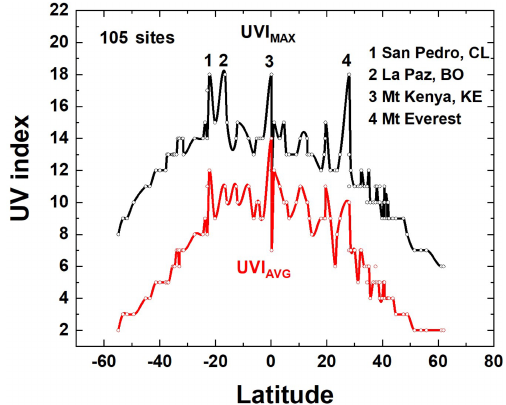
Figure 8. Fourteen-year UVI average and UVI maximum from Ta- ble A4 for 105 sites. Solid curves are Akima spline fits (Akima, 1970) to the individual site data points. There are four high-altitude sites listed: San Pedro, Chile (2.45km), La Paz, Bolivia (3.78km), Mt. Kenya, Kenya (5.2km), and Mt. Everest, Nepal and China